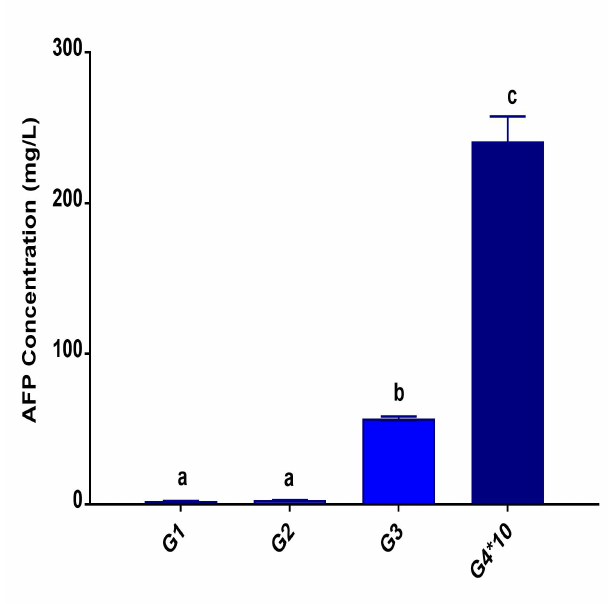
Figure 4. Comparison AFP concentrations in all studied groups. Each value represents the mean ± SEM. Means with di ff erent letters indicated the vari- ations between the groups within the same column using Turkey´s honestly significant di ff erence (p < 0.05) test. G1: Control group, G2: HCV-PCR nega- tive group, G3:HCV-PCR positive group, G4:hepatocellular carcinoma group.